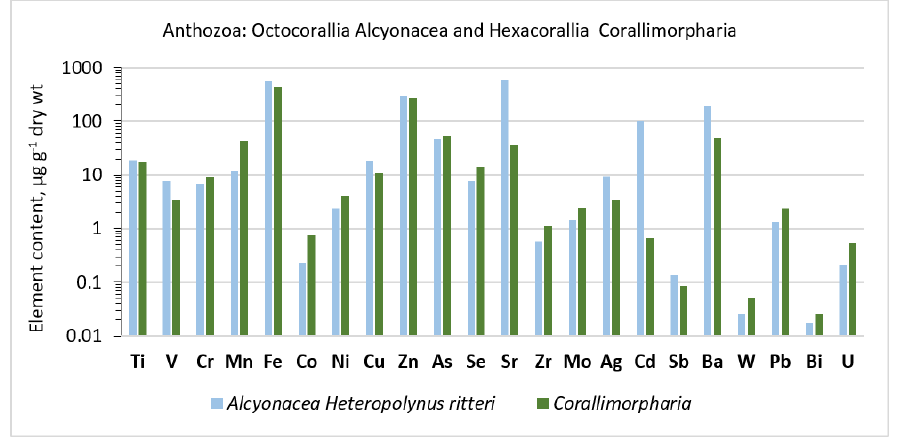
Figure 6. Distribution of elements in class Anthozoa: subclass Hexacorallia Zoantharia and Actiniaria. coral species were almost the same (Figure 7).